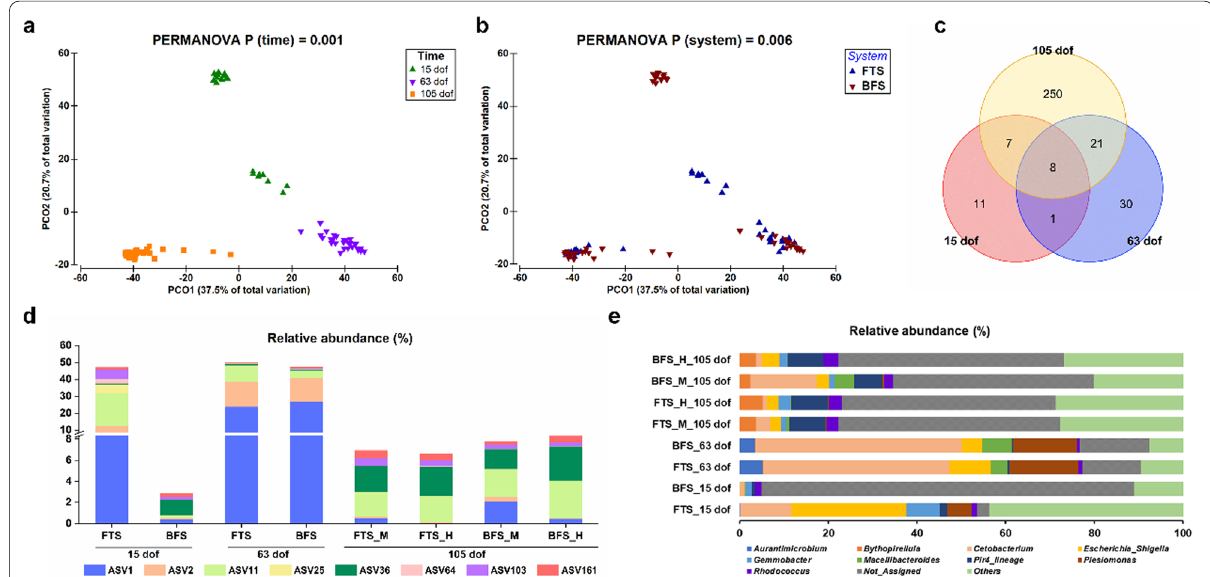
Fig. 5 Gut microbiome succession of fish reared in FTS or BFS during larval culture (Phase I). a Temporal (15, 63 and 105 dof) and b spatial (FTS vs BFS) impact on gut microbiome distribution by PCoA. c Shared ASVs among the three core microbiome communities, including 27 ASVs at 15 dof, 60 ASVs at 63 dof and 286 ASVs at 105 dof. d Variation of the eight shared ASVs among the three core microbiome communities in relative abundance between different treatments over time. ASV1, Cetobacterium somerae ; ASV2, Plesiomonas shigelloides ; ASV11, Escherichia_Shigella ; ASV25, Gordonia ; ASV36, Rhodococcus ; ASV64, Paraclostridium ; ASV103, Nocardia ; and ASV161, Pir4 _ lineage . e Variations of top 10 dominant genera in relative abundance between different treatments over time. FTS flow-through system, BFS biofloc system, M moderate NSP diet, H high NSP diet